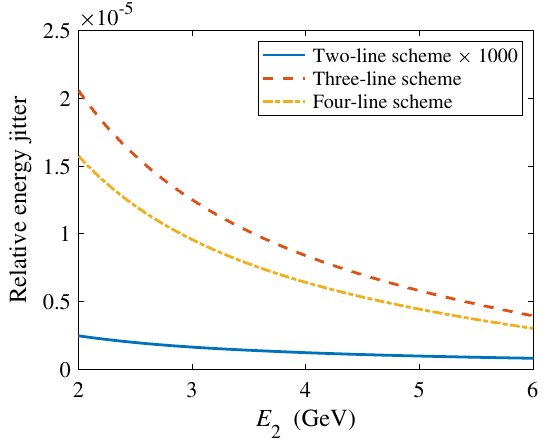
FIG. 7. Relative energy jitter of electron beam to SXR line in the three schemes considered for two undulator lines at the LCLS-II-HE. The standard deviation of acceleration phase jitter is σ ¼ 0 . 01 °.